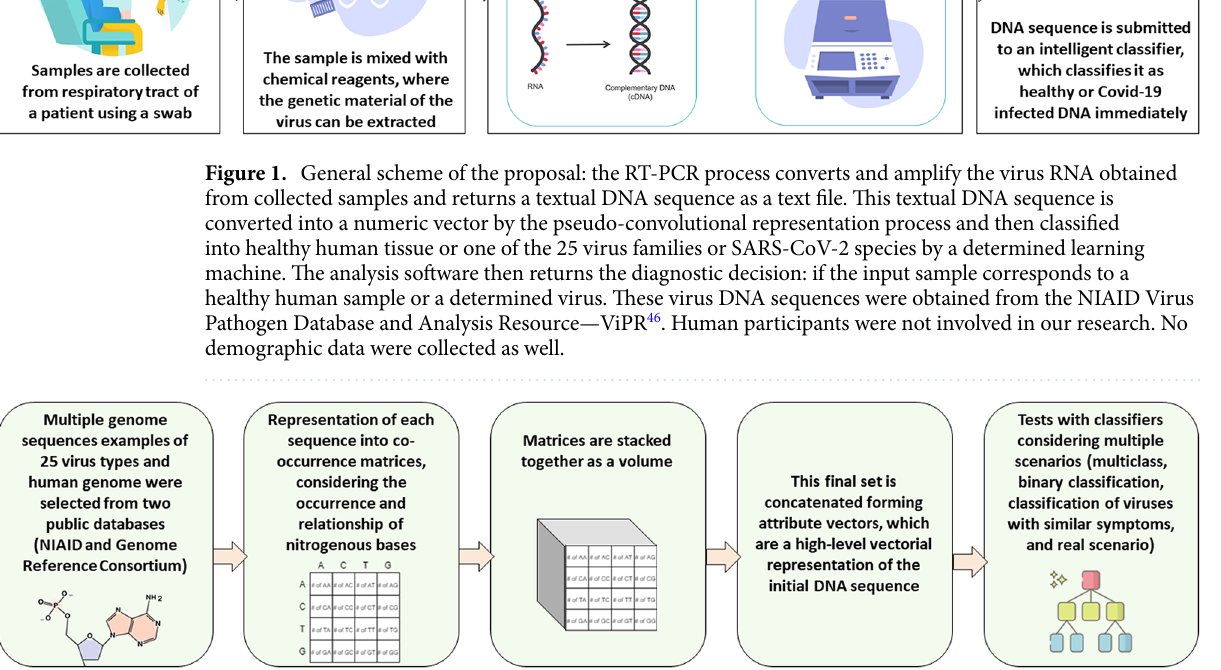
4 co-occurrence matrices representing the × 4 m volume is then stacked to generate the respective × ×